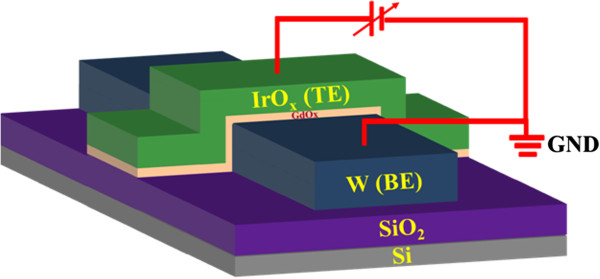
Schematic view of IrOx/GdOx/W cross-point memory device. Positive bias is applied at the TE, and BE was grounded during the measurement.